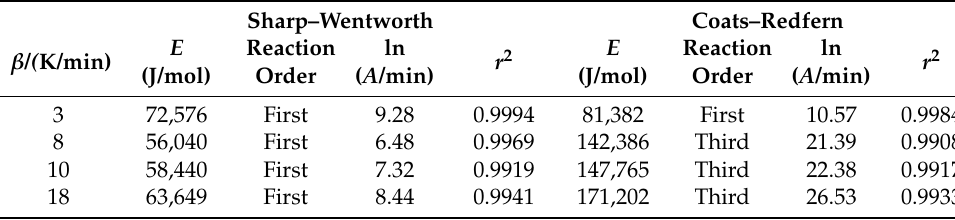
Table 4. The kinetic parameters of the reaction of Fe 3 O 4 → Fe based on the optimal correlation coefficient.